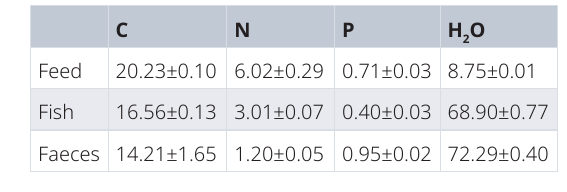
Table 1. Carbon (C), nitrogen (N) and phosphorus (P) composition (%) of the dry weight of the feed, harvested fish and faeces (±SD).